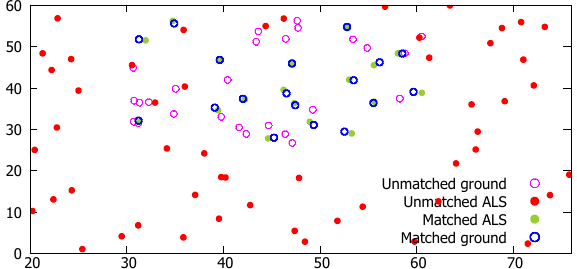
Figure 10: Coregistered tree positions on test plot (axes in